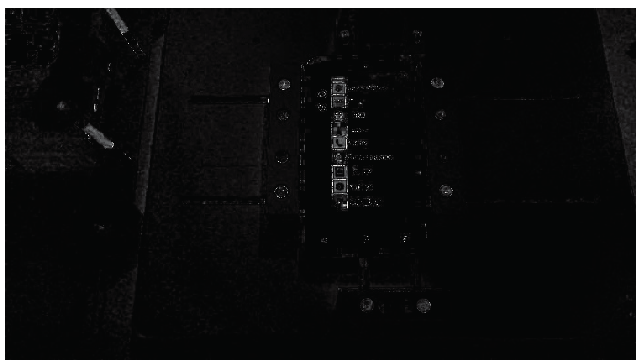
Figure 9. Using the H color space as the basis of the image operator.